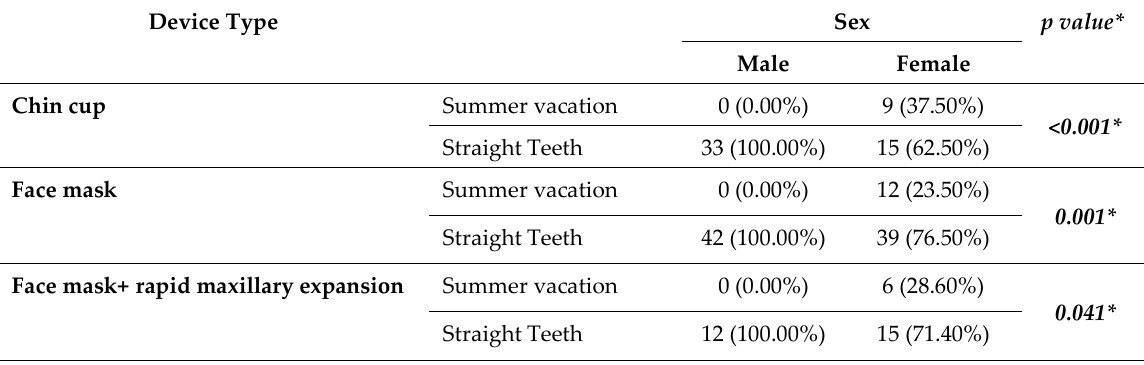
Table.2 : Orthodontic treatment preference according to device